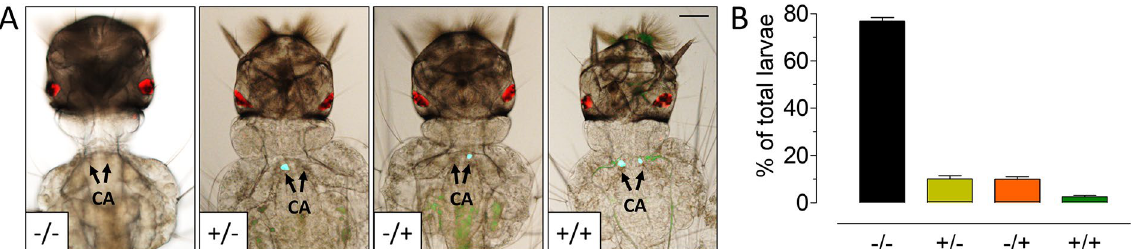
Figure 3. Asymmetric eGFP expression in CA: ( A ) Images of the four phenotypes of dsRed + first instar larvae expressing eGFP in the CA. −/−: both CA GFP negative; +/−: only right CA eGFP positive; −/+: only left CA eGFP positive; +/+: both CA eGFP positive. Scale bar, 100 µm. ( B ) Percentages of individuals expressing eGFP in the CA. −/−: both CA eGFP negative, +/−: only right CA eGFP positive, −/+: only left CA eGFP positive. +/+: both CA eGFP positive. Scale bar, 100 µm.